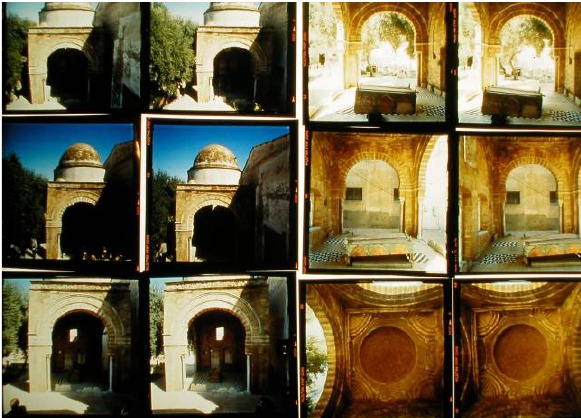
Figure 1. Set of photos used in the survey of the Qoubba Bou Khrissane in the Madina of